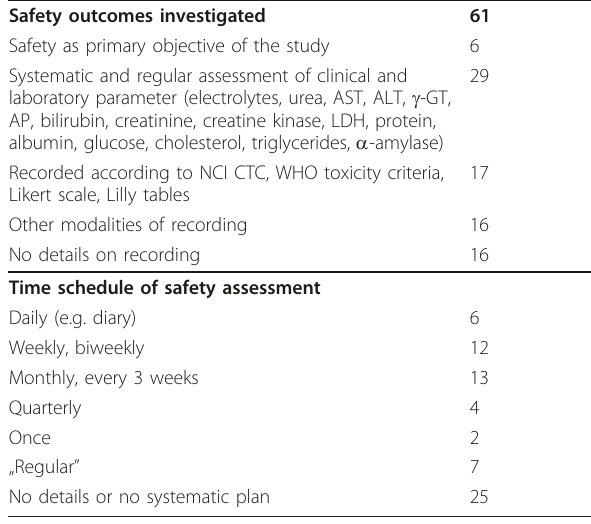
Table 2 Characteristics of the clinical studies (n = 69) Number of studies